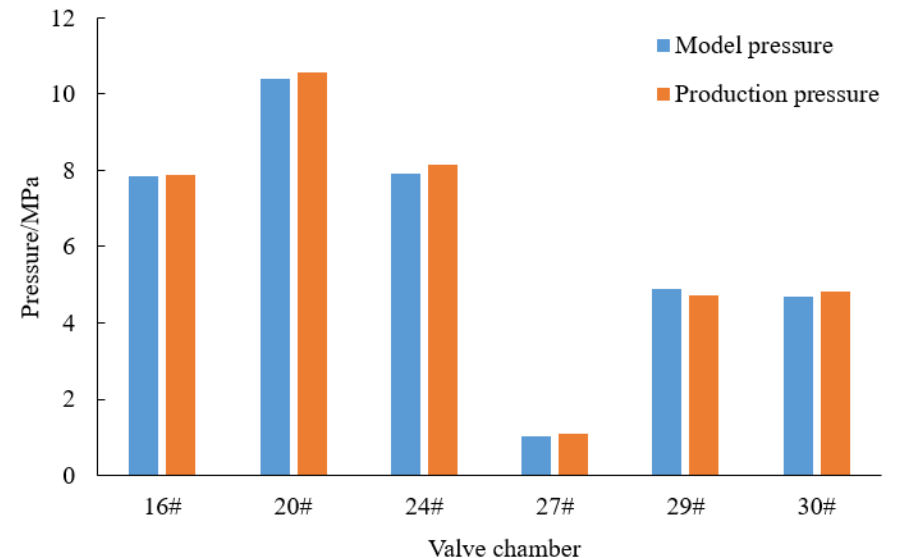
Figure 13. Comparison of the pressures at various valve chambers.